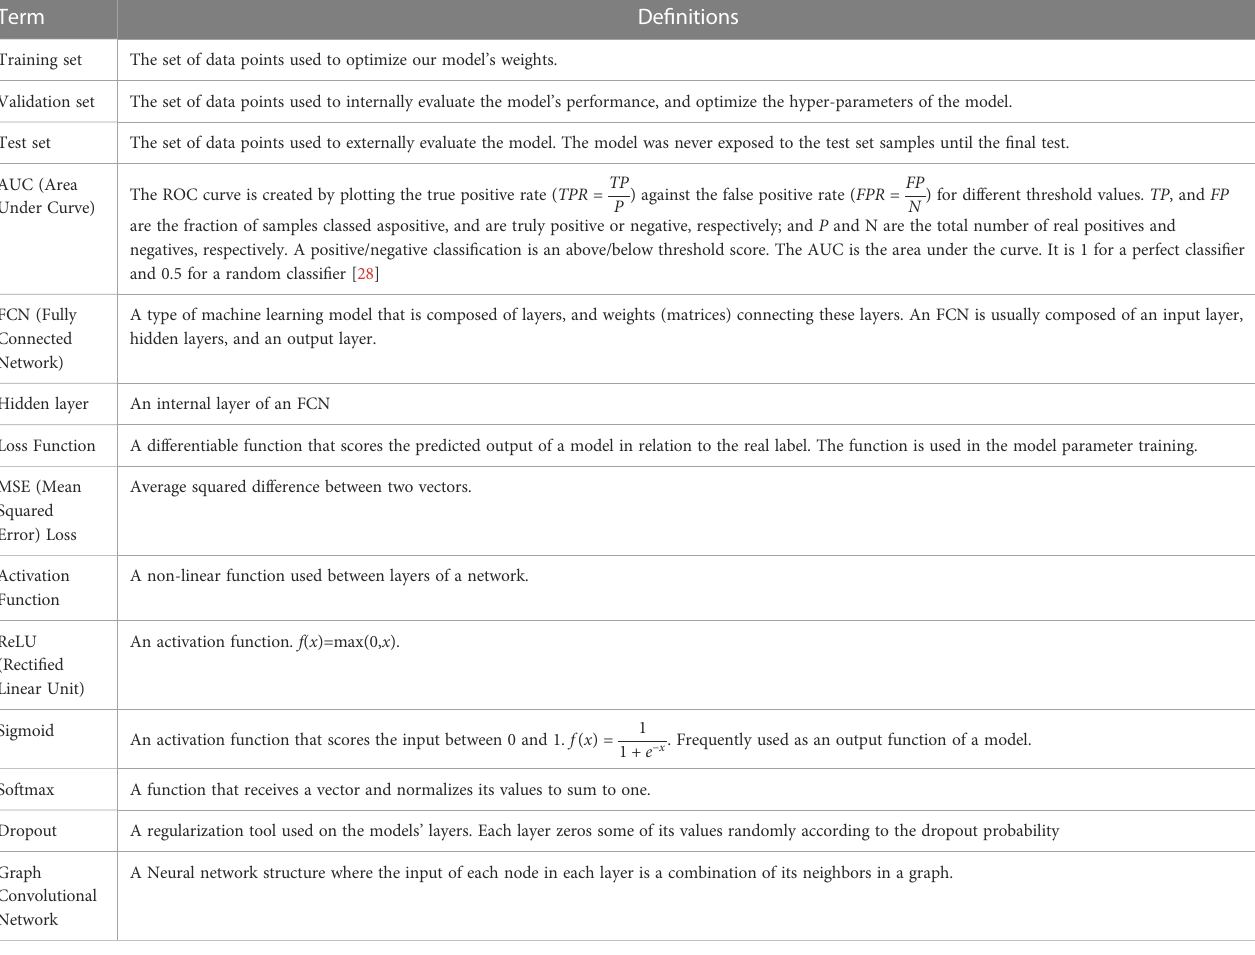
TABLE 1 Basic machine learning terms used in this paper and their de fi nitions. Term De fi nitions Training set The set of data points used to optimize our model ’ s weights. Validation set